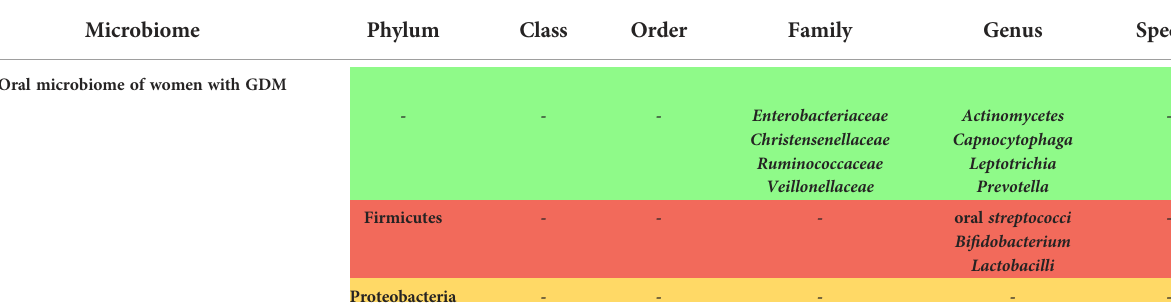
TABLE 3 Summary of the oral microbiome alterations in patients with GDM ( = Increased, = Decreased, = Variable).